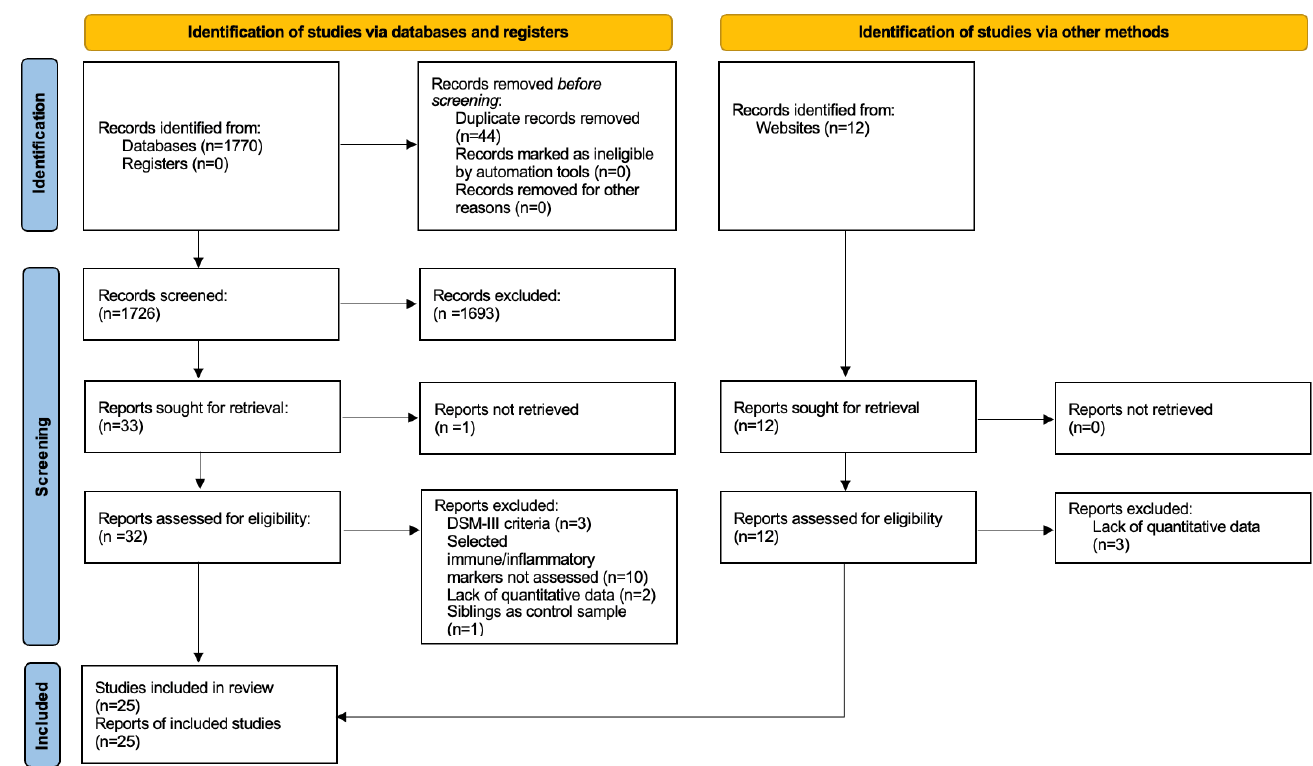
Figure 1. Flow chart of study selection